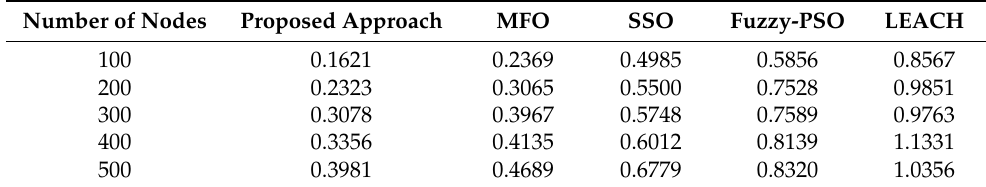
Figure 3. Analysis of energy consumption vs. number of nodes. Table 3. Comparison of energy consumption with various routing Table 4. Comparison of throughput with various routing protocols.